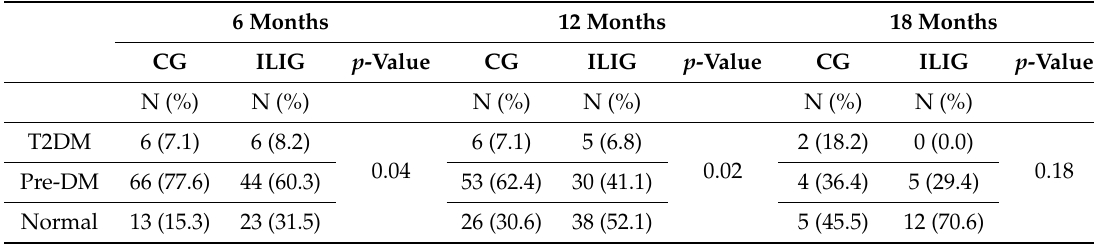
Table 4. T2DM of participants in di ff erent time